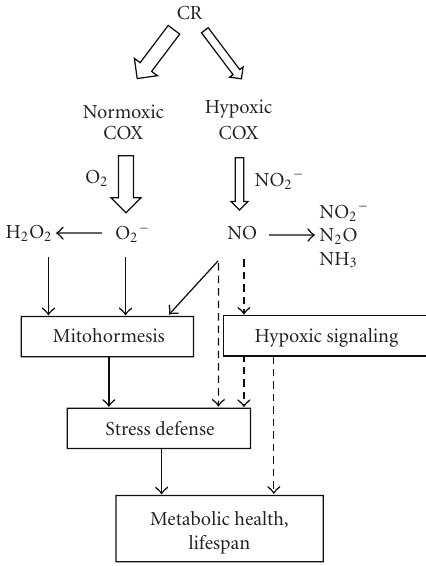
Figure 7: A proposed model for the roles of NO and mitochondrial respiration in CR. In yeast, the cytochrome c oxidase (COX) is likely to be responsible for CR-induced NO production. Under normoxic conditions, CR can activate both oxygen-dependent respiration and nitrite-dependent NO production, and both require the cytochrome c oxidase (COX). CR may increase NO produc- tion by derepressing expression of the hypoxic isoform subunits of COX and cytochrome c, which are normally repressed by oxygen. ROS detoxification enzymes protect cells from various ROS-associated damages and are required for certain CR-induced beneficial e ff ects. NO and other mitochondrial ROS may induce adaptive gene expression changes as well as a metabolic shift, which optimize metabolism and improve cellular defense system against the oxidative stress that accumulates with age. For clarity and simplicity, many important longevity factors are not shown. Other pathways may work independently or in concert with mitochondrial respiration and stress response to mediate